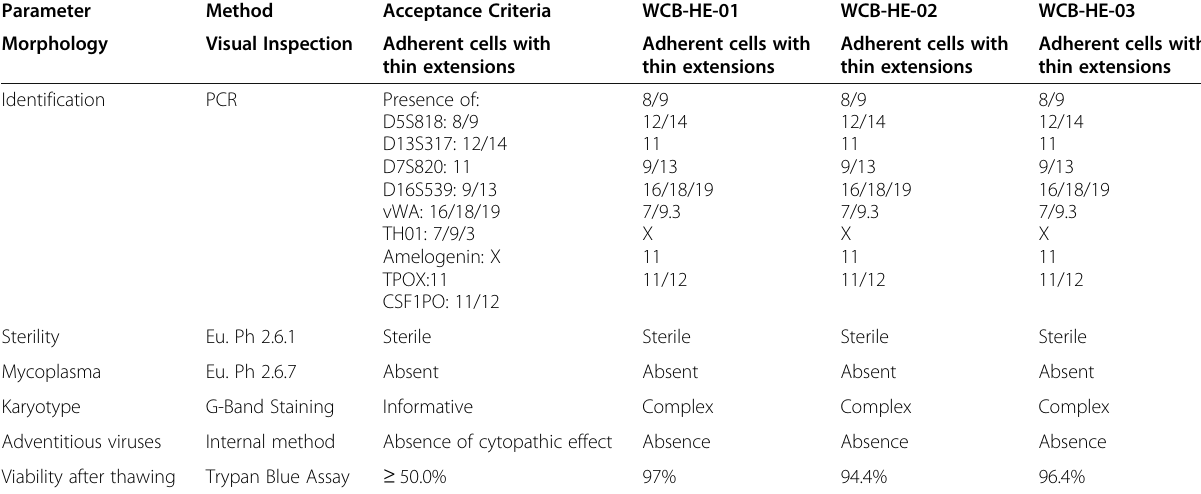
Table 4 WCB specifications. Table summarizing results obtained during the analyses of WCB batches. All WCB batches met